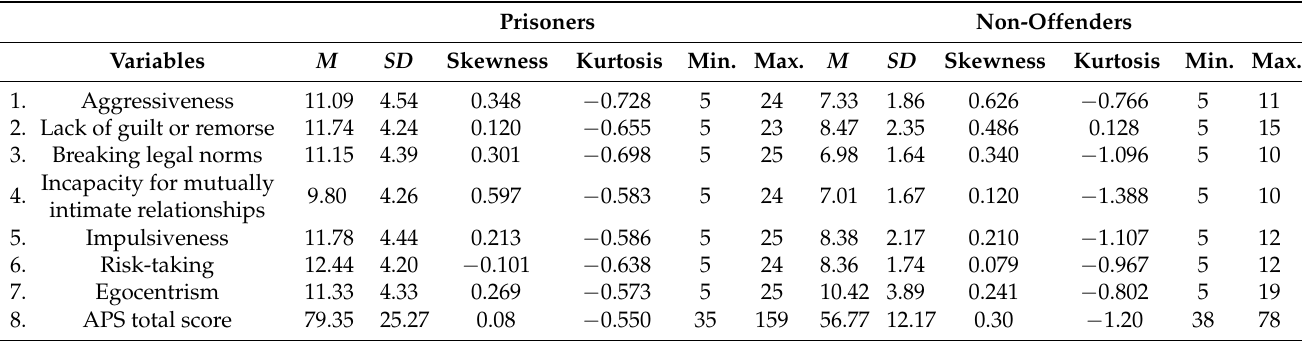
Table 2. Descriptive statistics for APS factors: prisoners ( N = 718); non-offenders ( N = 339).